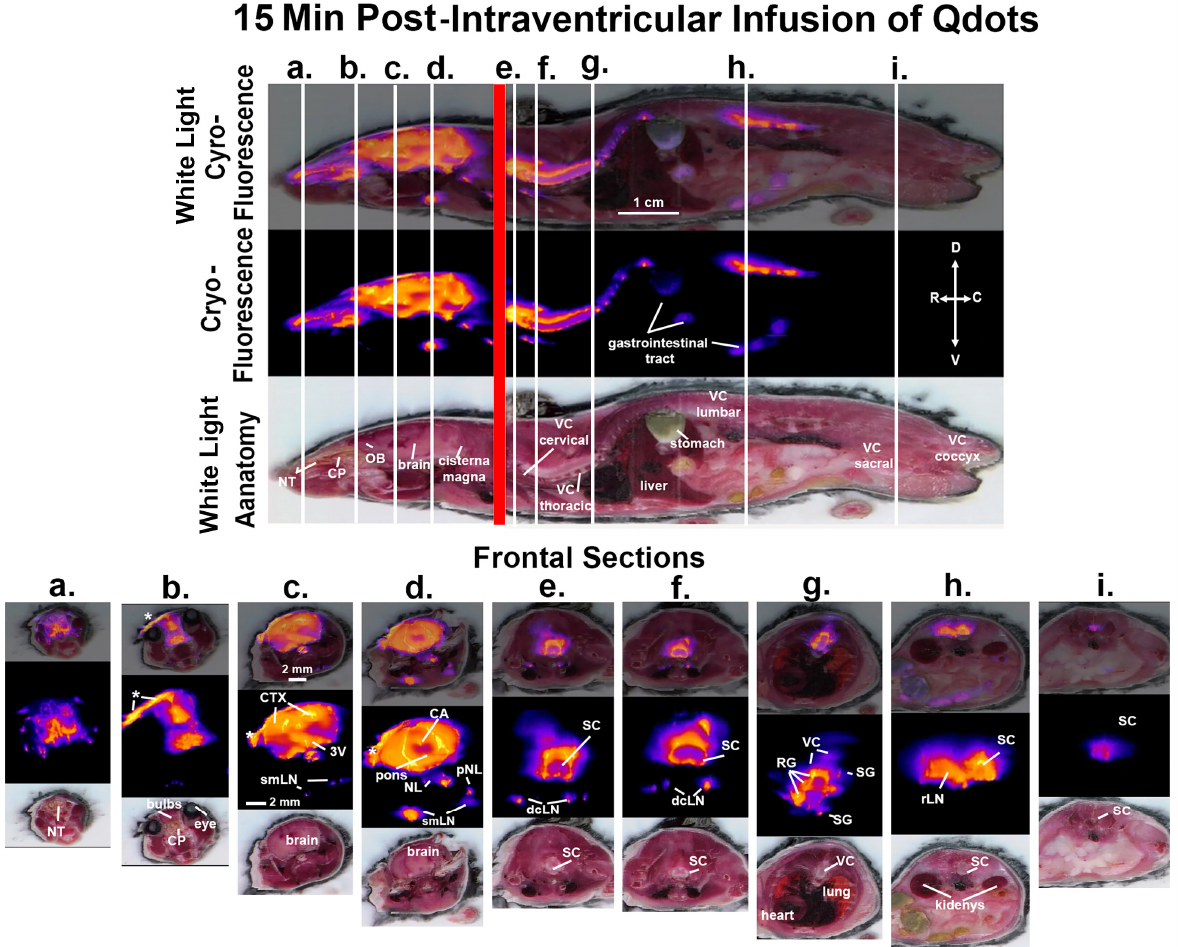
Figure 2. CNS distribution and clearance at 15 min. Shown above are sagittal sections depicting the same mouse imaged for white light anatomy, cryo-fluorescence, and both together at 15 min post infusion of ICV Qdots. The head of the mouse and the body were not in plane, hence the red line demarking the intersection of the separate images. The perpendicular white lines labeled ( a. – i. ) denote the position of the frontal sections shown below. Abbreviations: NT—nasoturbinates; CP—cribriform plate; CTX—cortex; 3V—third ventricle; smLN—submandibular lymphatic nodes; CA—cerebral aqueduct; NL—nasal lymphatics; pNL—parotid lymphatic nodes; SC—cervical spinal cord; dcLN—deep cervical lymph nodes; VC—thoracic vertebra; RG—root ganglia; SG—sympathetic ganglia; rLN—renal lymph nodes. Scale bar for sagittal sections is 1 cm. Scale bar for frontal sections is 2 mm.